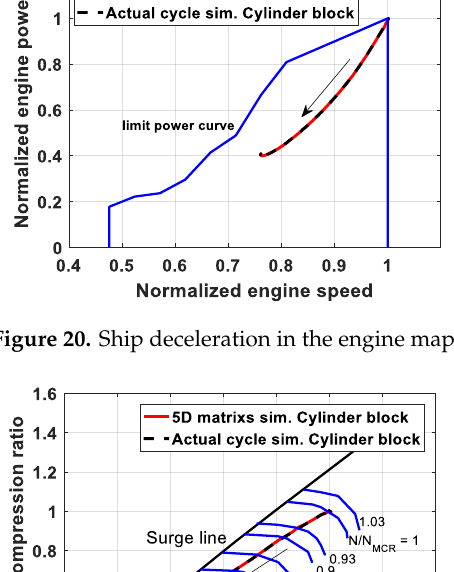
Figure 21. TC deceleration in the compressor map.